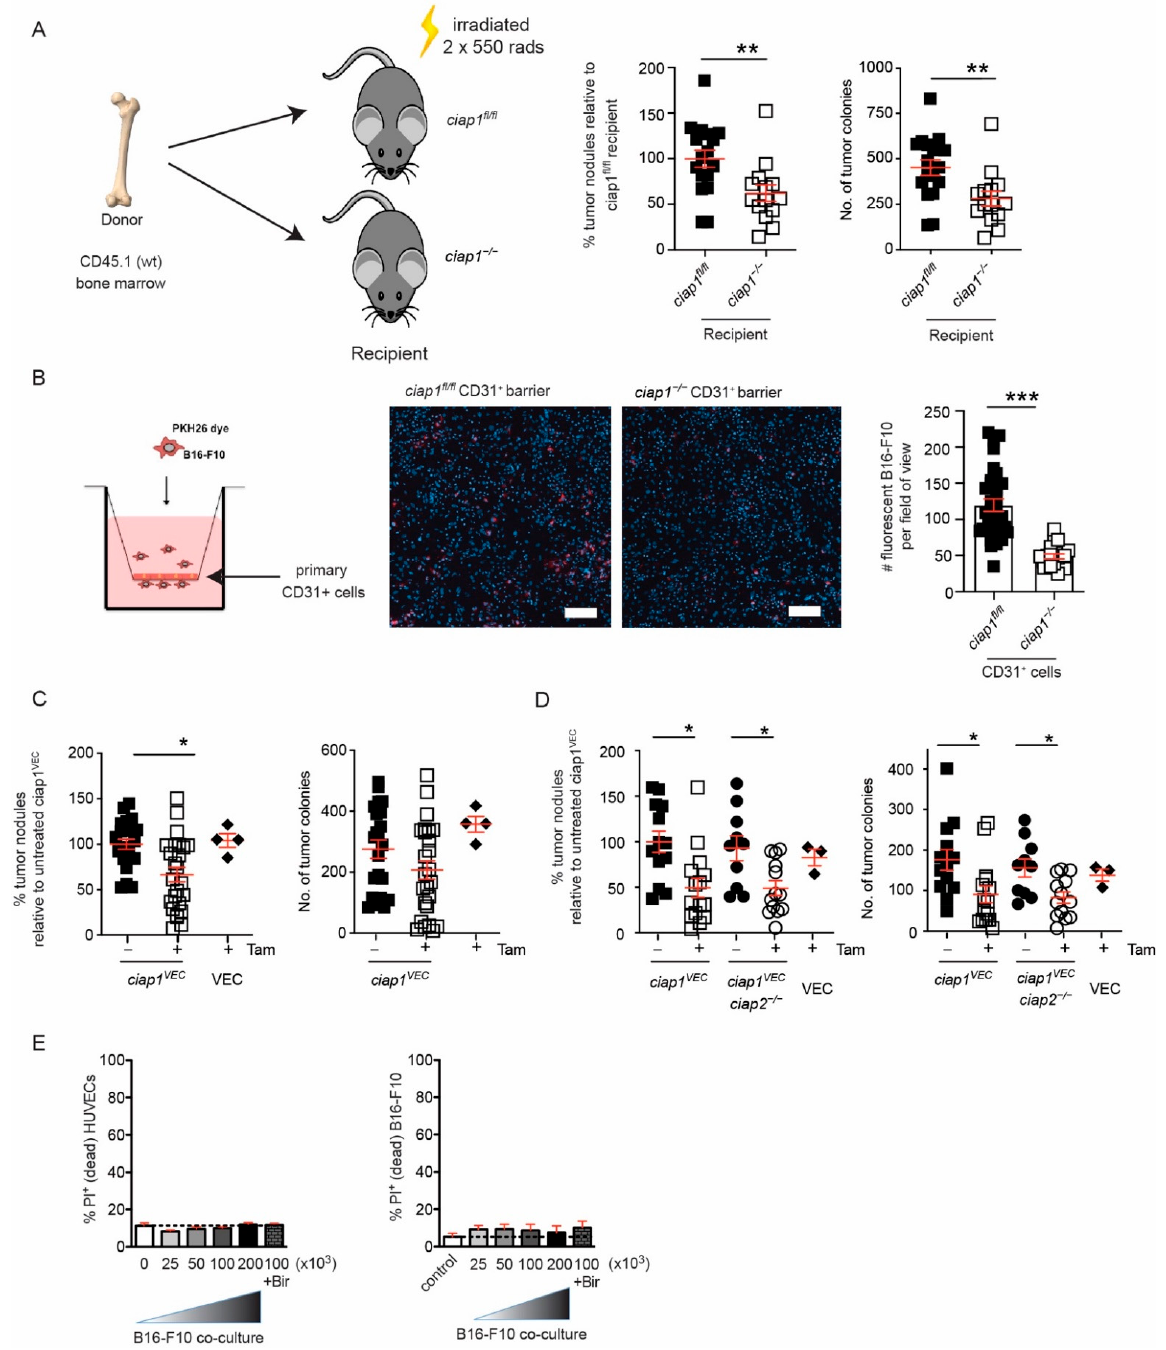
Figure 4. Transmigration of tumors is reduced due to loss of cIAP1 in endothelium barrier. ( A ) ciap1 fl/fl and ciap1 − / − mice were reconstituted with wildtype (CD45.1) bone marrow. Mice were challenged with B16-F10 tumors and lung nodules were counted 13 days later. Data shows the percentage of superficial B16-F10 tumor nodules from an individual mouse normalized to the average number of tumor nodules counted in the wildtype recipient control of an individual experiment. Primary tumor nodule count is also shown. ( B ) Transendothelial migration assays were performed with CellVue Plum-stained B16-F10 cells over a monolayer of primary isolated endothelial cells. Representative images of transwells demonstrating the amount of migrated CellVue Plum+ B16-F10 cells (red) surrounded by endothelial cells stained only with DAPI (blue). Scale bar is 100 µ m. Each dot represents the number of manually counted CellVue Plum+ B16-F10 cells/field of view or image tile. n = 4–8 biological replicates. ( C ) ciap1 VEC mice are challenged with B16-F10 tumor cells and tumor nodules are counted 13 days post injection. Percentage of superficial B16-F10 tumor nodules in ciap1 VEC , VEC mice with and without tamoxifen (tam) oral gavage normalized to the average number of tumor nodules identified in ciap1 VEC